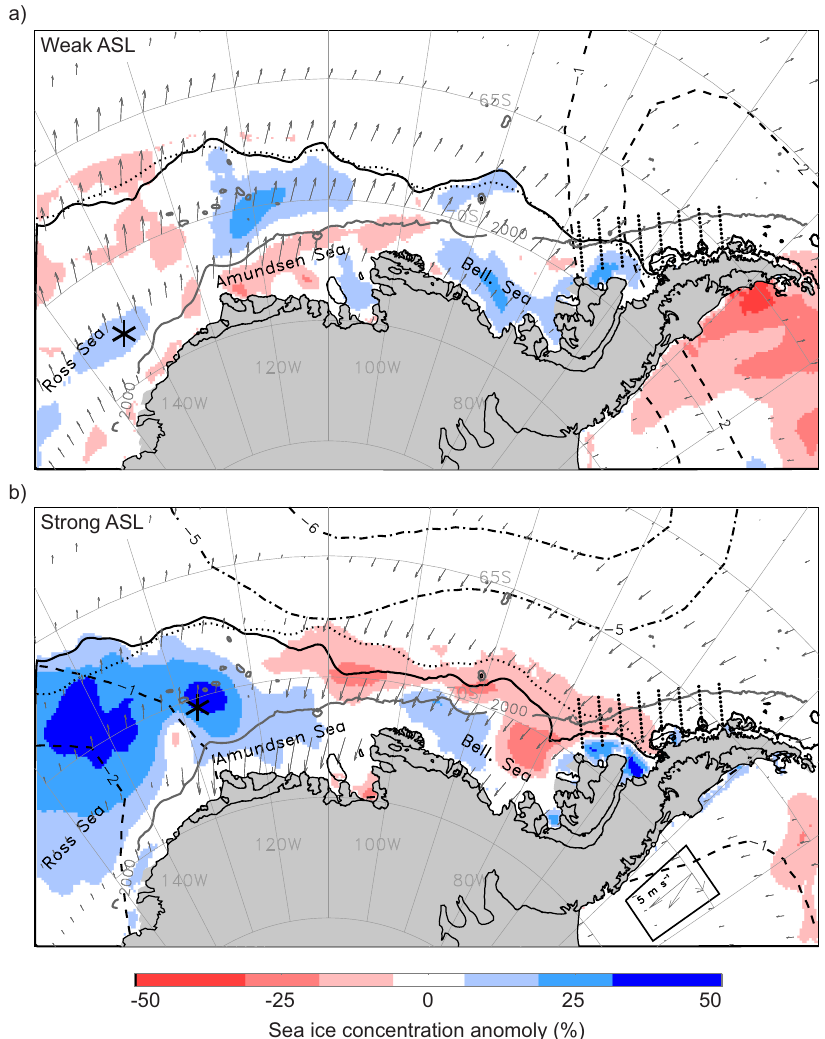
Fig. 1 Impact of the Amundsen Sea Low (ASL) on the West Antarctic environment. a Averaged environmental conditions for the duration of an especially weak (shallow; relative central pressure, RCP, of − 6) ASL event during March – April – May (MAM) 1993. The ASL central location is marked by the black asterisk and the Palmer Antarctica Long-Term Ecological Research program study region and sampling stations are depicted by eight lines of small black dots. Sea ice concentration anomalies are color shaded and the MAM 1993 mean ice edge contour (solid black line) and long-term (1979 – 2019) mean contour (dotted black line) are also marked. Subsampled wind anomalies are shown in vector format. The negative sea-level pressure (SLP) anomalies are shown for the most negative feature during MAM 1993 (dashed concentric contours). b The same averaged environmental conditions and symbology as in a but for the duration of an especially strong (deep; RCP of − 16) ASL event during MAM 1996. The wind-vector legend for both 1993 and 1996 is boxed in the lower right